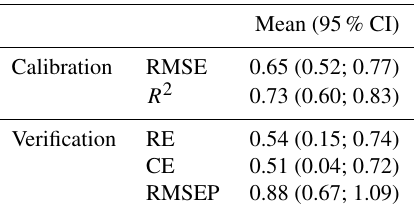
Table 4. Calibration and verification statistics of the bootstrap method (1000 iterations applied) showing the mean values based on the 95% confidence interval (CI).